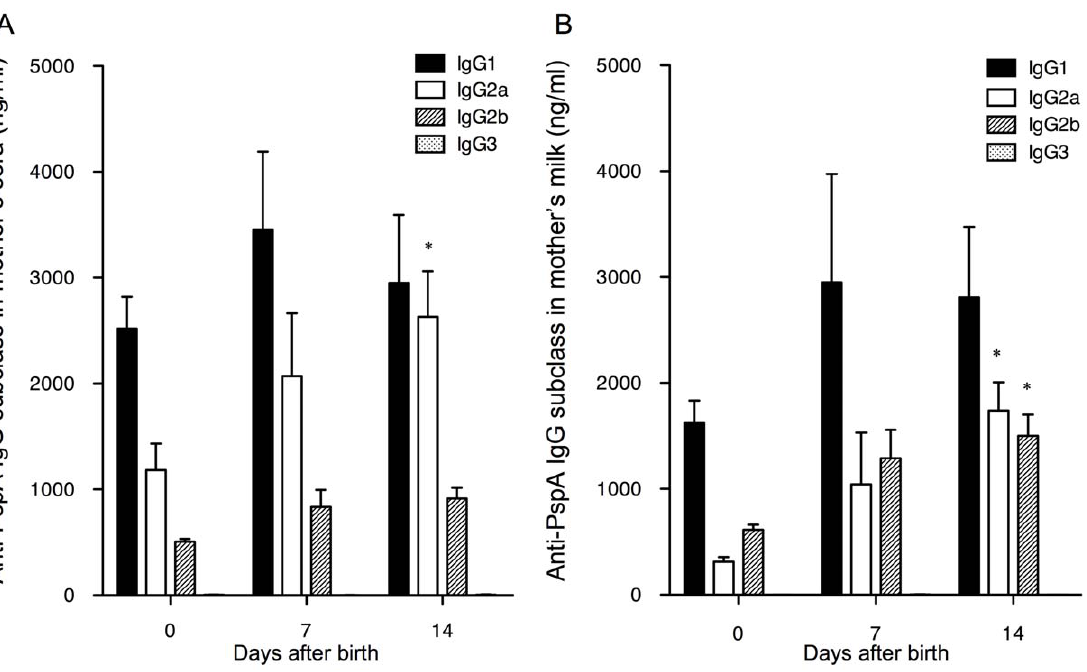
Figure 2. Anti-PspA specific IgG subclasses in sera and milk of mother mice. Female mice were intranasally immunized twice each week with 1 m g of rPspA and 4 m g CTB for first 2 weeks and with 1 m g rPspA alone for the last week. The levels of anti-PspA specific IgG1, IgG2a, IgG2b and IgG3 antibodies in sera (A) and breast milk (B) were determined by PspA-specific ELISA on day 0, 7 and 14 after the birth. The values shown are the mean 6 S.E. concentrations (ng/ml) taken from PspA-immunized mother (n=16) and sham-immunized mother (n=14). The mean values of IgG1/ IgG2a antibody to PspA in the sera of the individual mother’s sera were 3.1, 2.1 and 1.1 for day 0, 7, and 14, respectively. The mean IgG1/IgG2a anti- PspA values for the individual mother’s milk samples were 5.7, 6.5, and 1.7 for day 0, 7, and 14, respectively. The levels of anti-PspA specific IgG subclasses in sera and breast milk from sham-immunized mice were below the detections limit. * p , 0.05 when compared with mice at day 0 by ANOVA test or Kruskal-Wallis test with Dunn’s multiple comparison test. n.d. not determined.